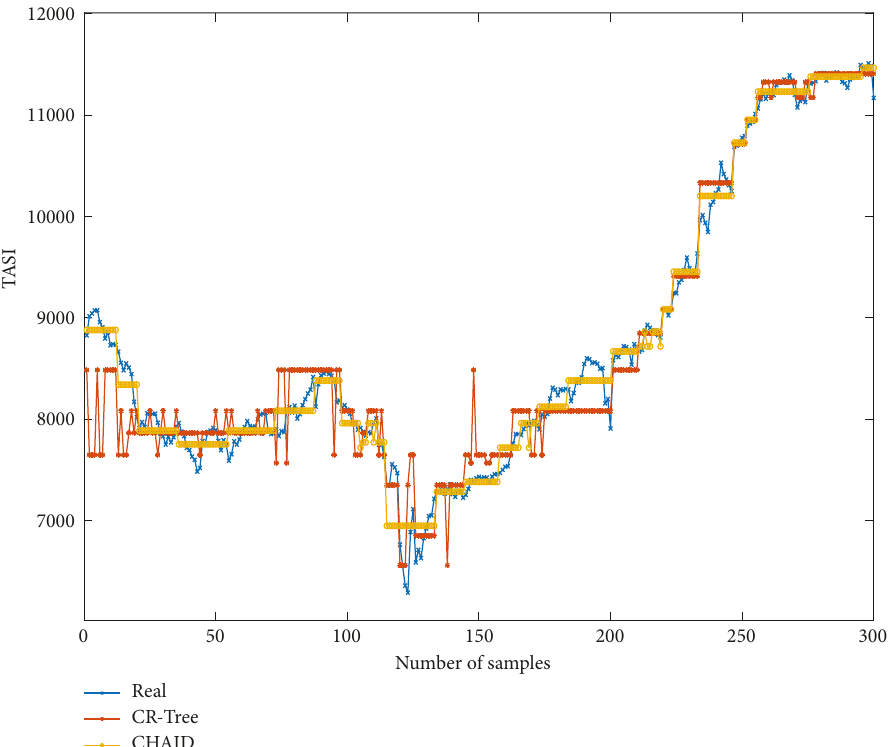
Figure 3: The relationship between all samples and the TASI value using real, CR-Tree, and CHAID models.